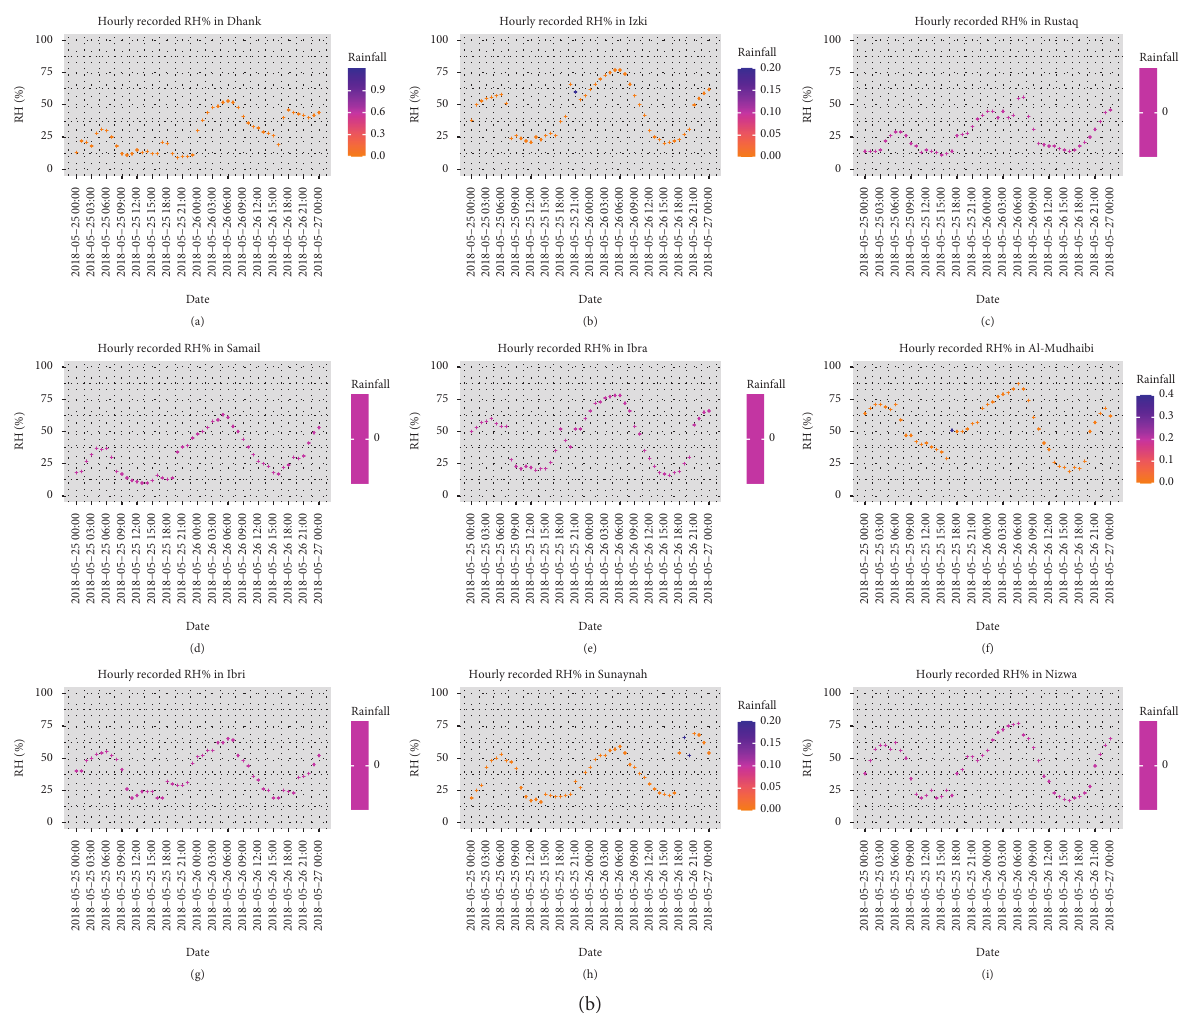
Figure 18: (a) Hourly temperature variation in ° C with respect to the wind direction at some weather stations on the Al-Hajar Mountains during TC “Mekunu.” (b) Hourly RH% variation with respect to the wind direction at some weather stations on the Al-Hajar Mountains during TC “Mekunu.”